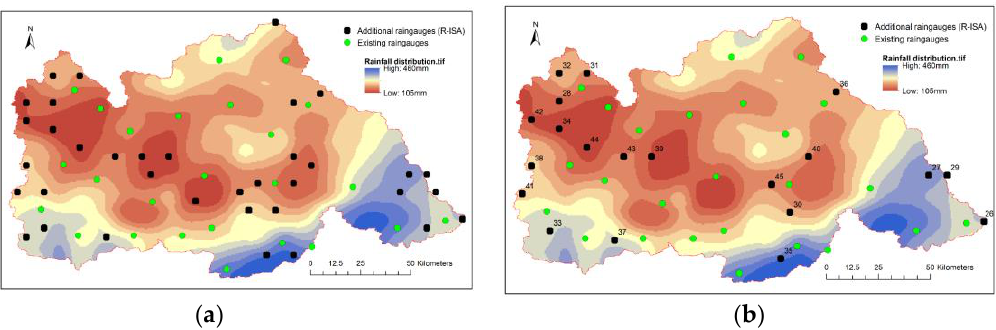
Figure 12. Optimal design of the R-ISA method. ( a ) Network of 60 rain gauges and ( b ) network of 45 rain gauges.